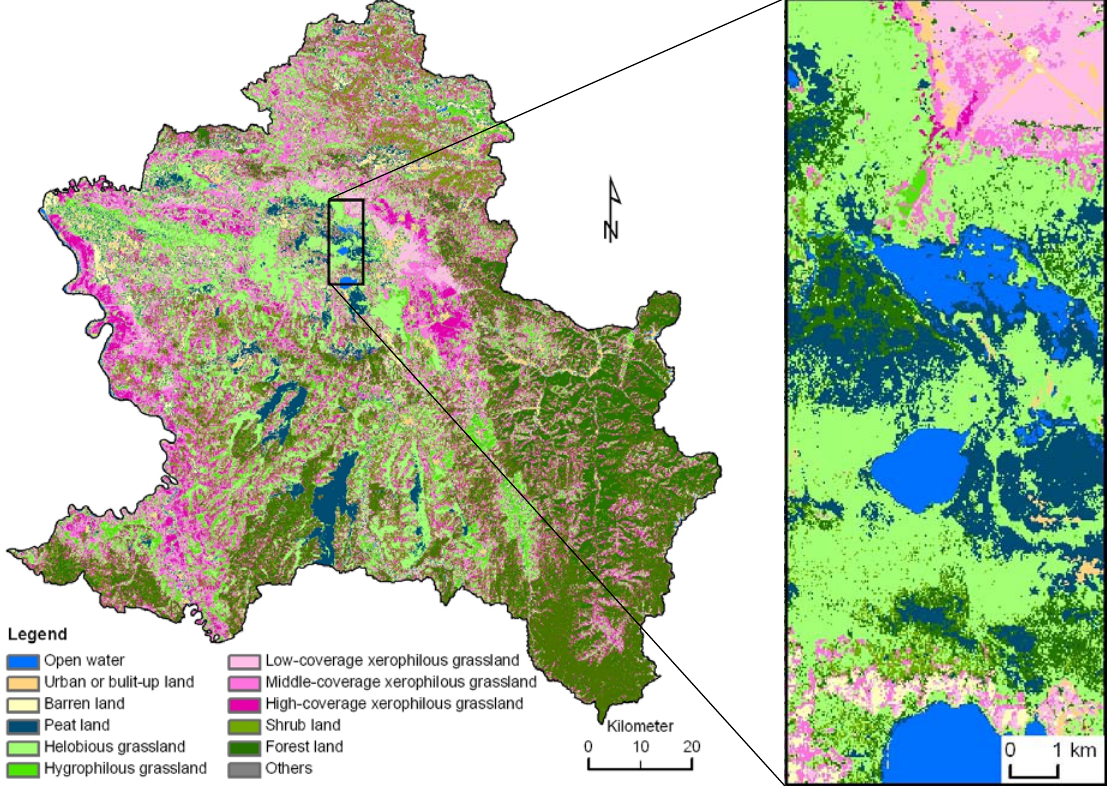
Figure 2. Land cover map of the Zoige County. The left part is the overall map and its legend, and the right part is an enlarged map in the black box of the left part, reflecting the detailed vegetation cover of the wetland transition